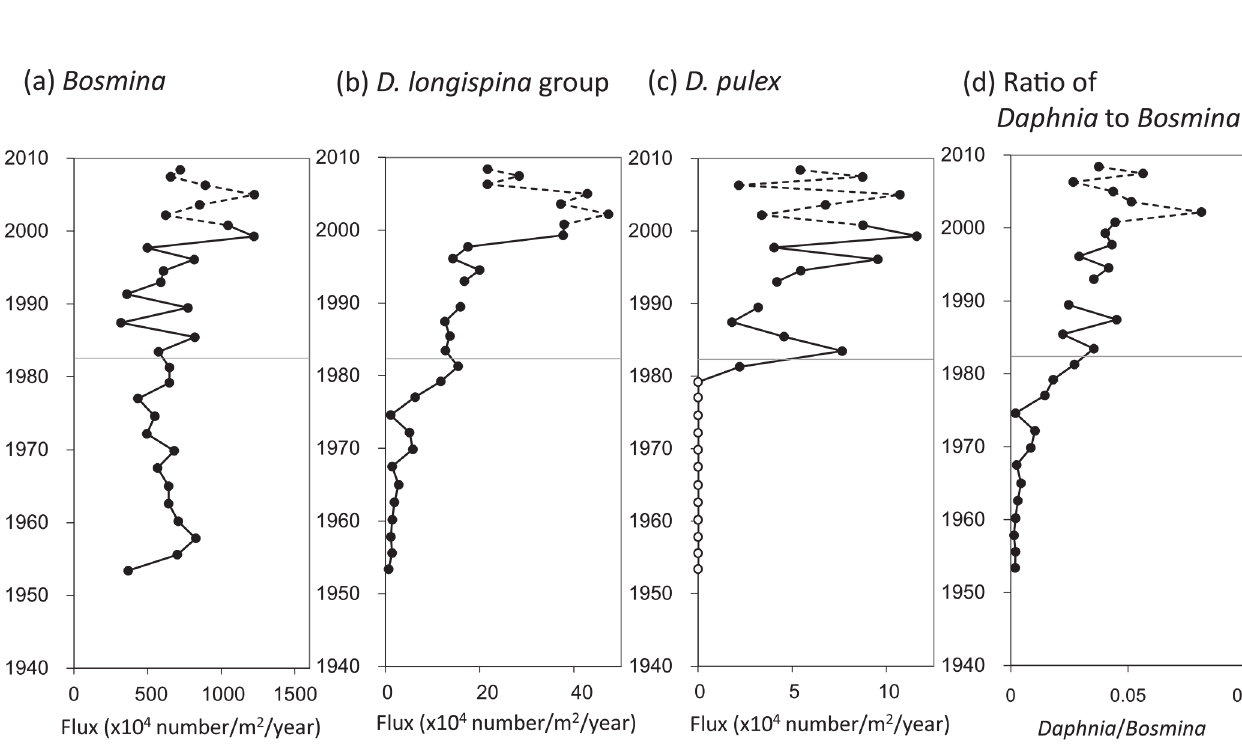
Fig 6. Fluxes of crustacean zooplankton remains. Fluxes of inaccurately estimated chronological years are denoted by broken lines. Two distinct periods (I and II) from the cluster analysis in Fig. 4 are divided by a thin line.